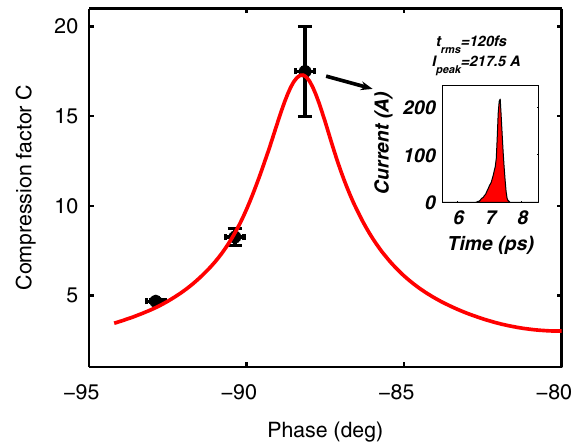
FIG. 17. Compression factor versus rf injection phase for the 60 pC case. The red curve is the compression curve simulated by PARMELA . On the top-right shows the reported slice current for the maximum compression factor.